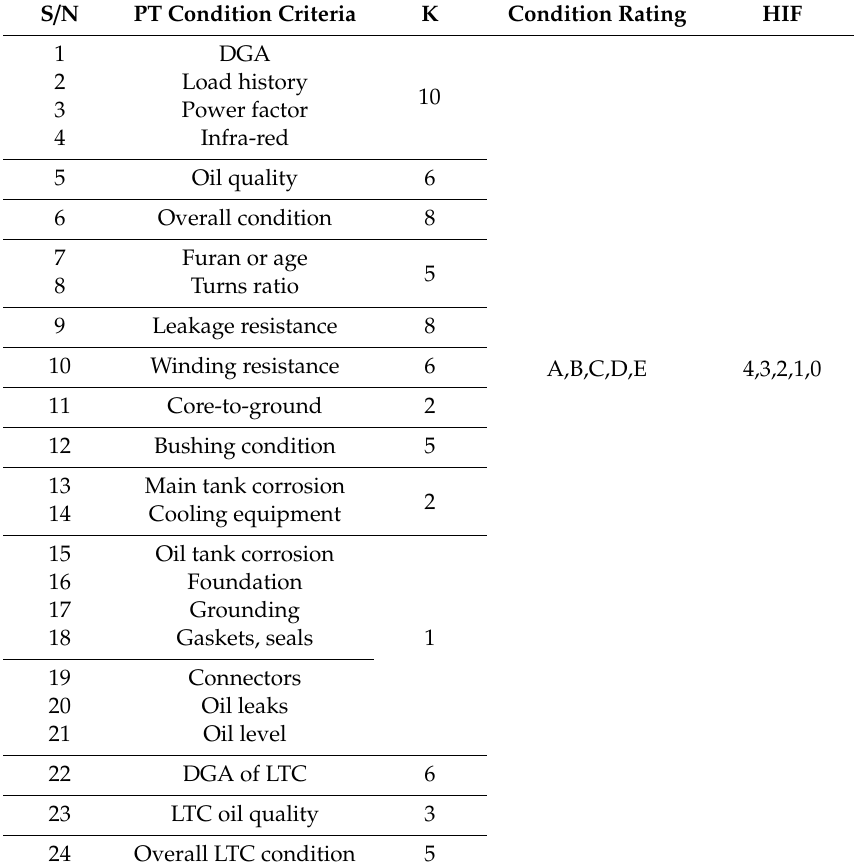
Table A11. Typical PT health index scoring chart.